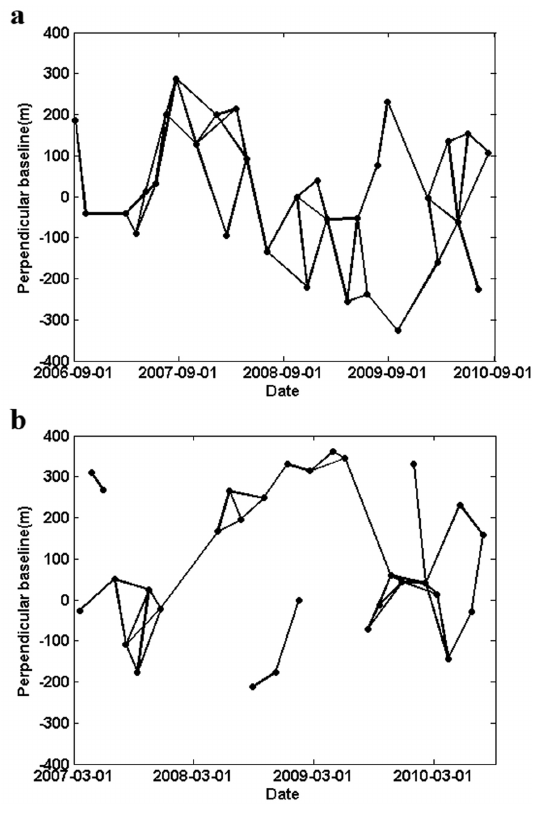
Fig. 2. Baseline-time plots relevant to the ASAR images and inter- ferograms used in this study; (a) Track 25, (b) Track 297.